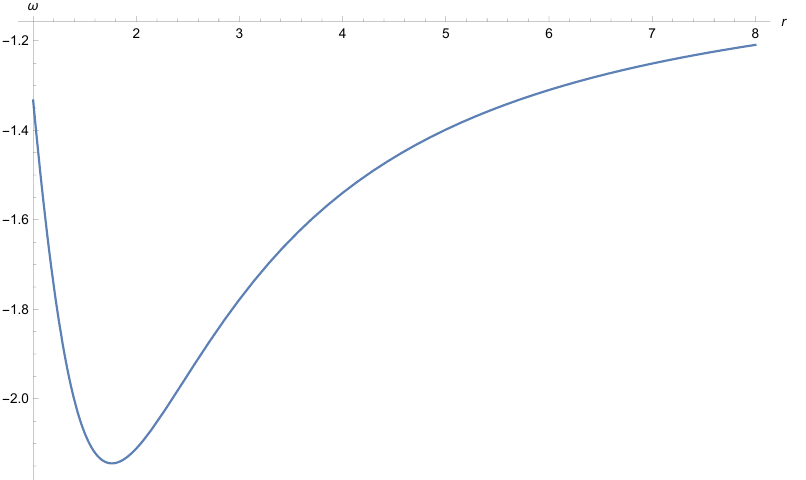
Figure 3. Plot of ω ( r ) for a zero-tidal Schwarzschild-like wormhole for r 0 = 1 < r , ξ = 1 and β = 1/2, in Planckian